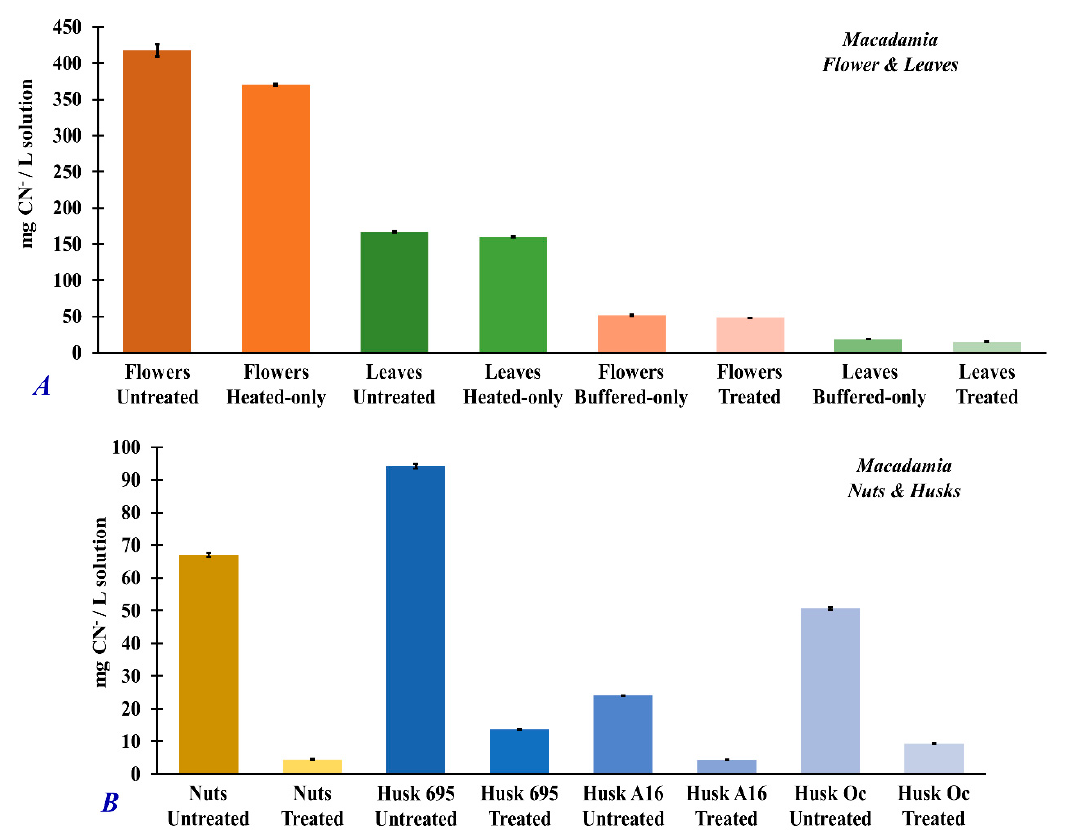
Figure 7. Total cyanide concentration (mg CN − / L solution) measured by UV–vis spectrophotometer from the different extracts of Macadamia plant parts (( A ) flowers and leaves; ( B ) nuts and husk varieties 695, A16, and Oc ) in untreated samples (fresh, no treatment), heated-only samples (samples heated at 50 °C for 60 min), buffered-only samples (samples treated with pH 7, Na 2 HPO 4 –citric acid buffer solution), and treated samples (samples treated with pH 7, Na 2 HPO 4 –citric acid buffer solution, and heated at 50 °C for 60 min). Standard error analysis was evaluated at 95% confidence intervals. Table 2. Dhurrin and total cyanide (mg / g sample) in untreated and treated Macadamia flowers, leaves, nuts, and husk varieties and treatment removal e ffi ciency